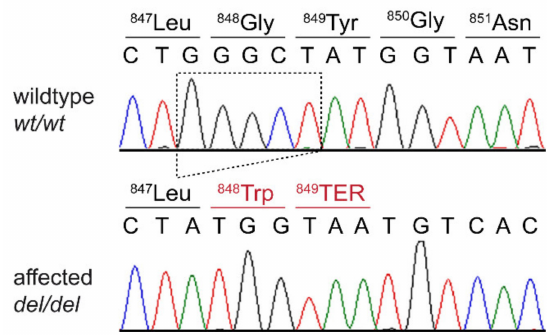
Figure 3. Details of the DSG1 :c.2541_2545delGGGCT variant. Representative electropherograms of a control and the a ff ected dog are shown. The amino acid translations of the wild-type and mutant alleles are